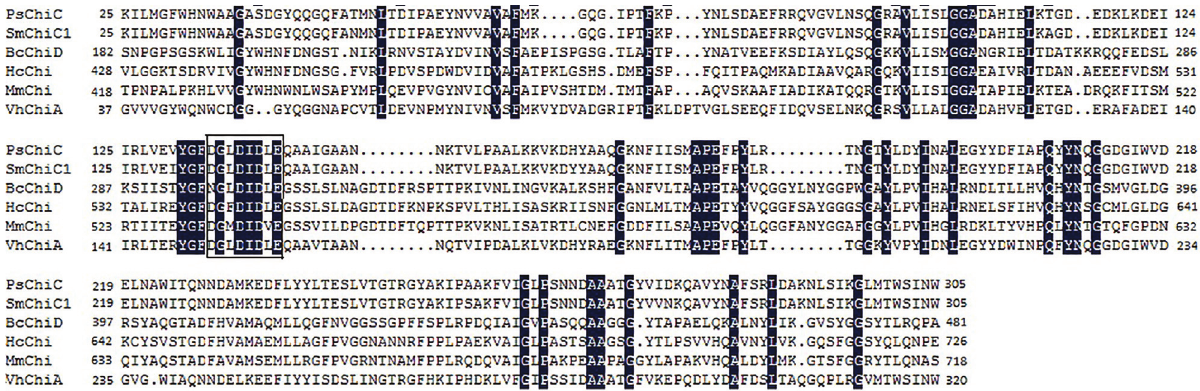
Figure 2 - Amino acid sequence alignment of the catalytic regions of PsChiC and several bacterial chitinases. PsChiC - Pseudomonas sp. TXG6-1 chitinase C (this study), VhChiA - Vibrio harveyi chitinase A (AAC46383), SmChiC1 - Serratia marcescens chitinase C1 (CAF74787), BcChiD - Bacil-